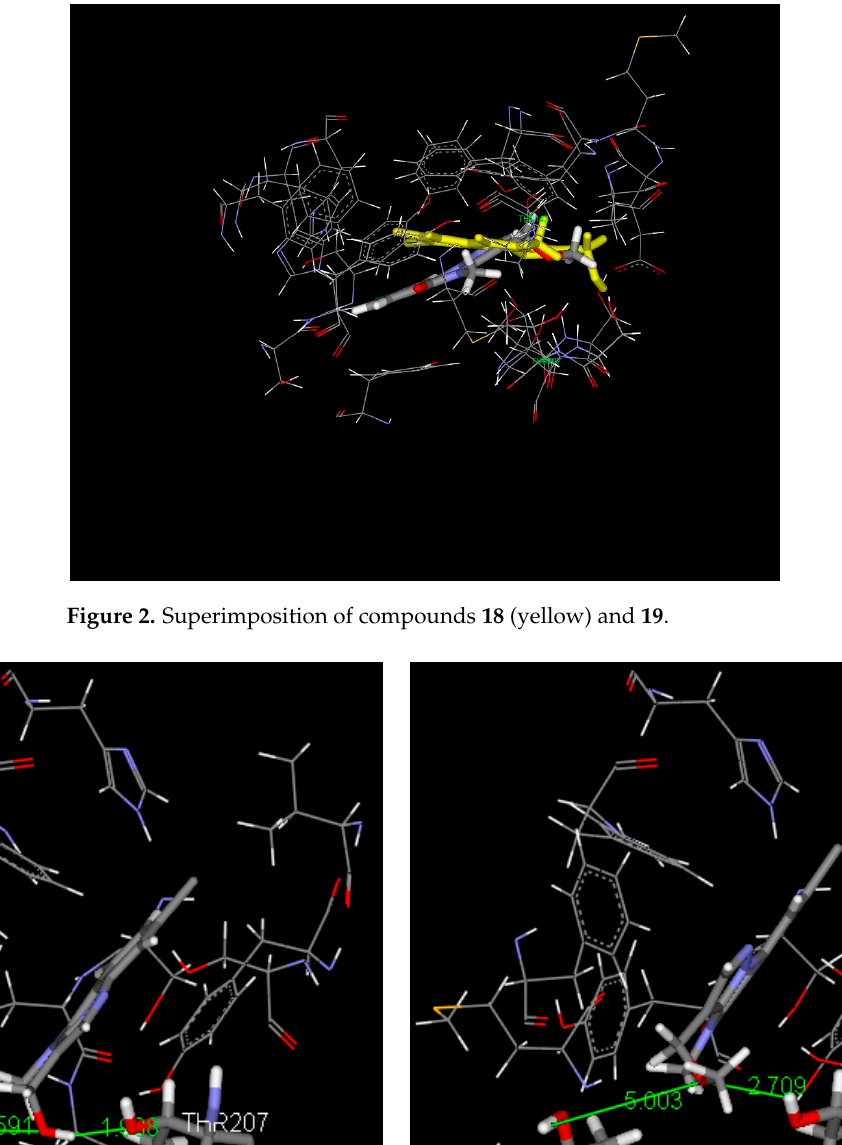
Figure 2. Superimposition of compounds 18 (yellow) and 19 .